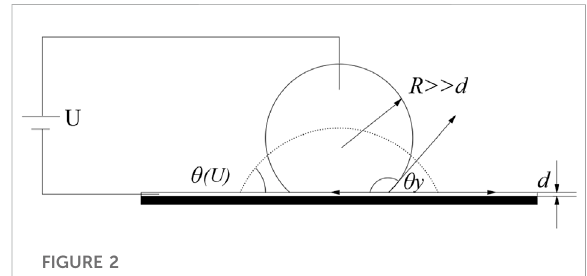
FIGURE 2 The basic model of an EWOD experiment.